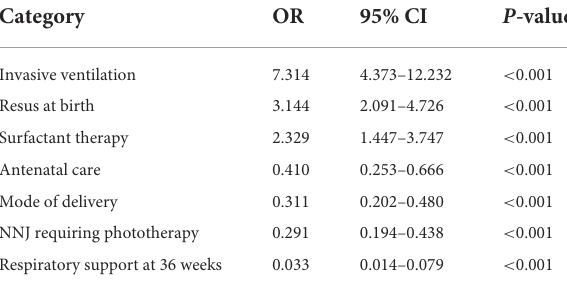
TABLE 4 Multivariate logistic regression for factors associated with mortality in very low birth weight infants at Charlotte Maxeke Johannesburg Academic